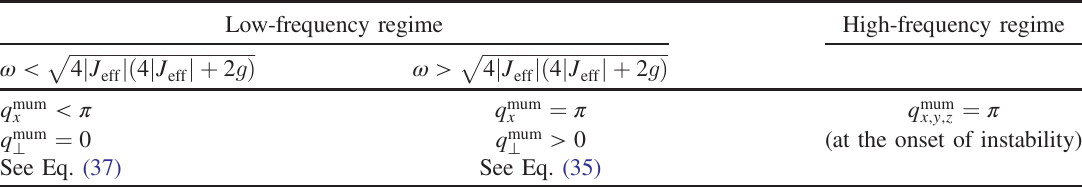
TABLE II. Characterization of the most unstable mode (mum) for various relevant regimes. The low-frequency regime is generically defined through the criterion according to which the drive frequency ω is smaller than the effective free-particle bandwidth (e.g., ω < 4 j J for the 1D shaken-lattice model of Sec. III A). We stress that the eff j effective free-particle dispersion is unbounded for models involving a continuous spatial dimension, in which case the system necessarily corresponds to the low-frequency regime (for all ω ).